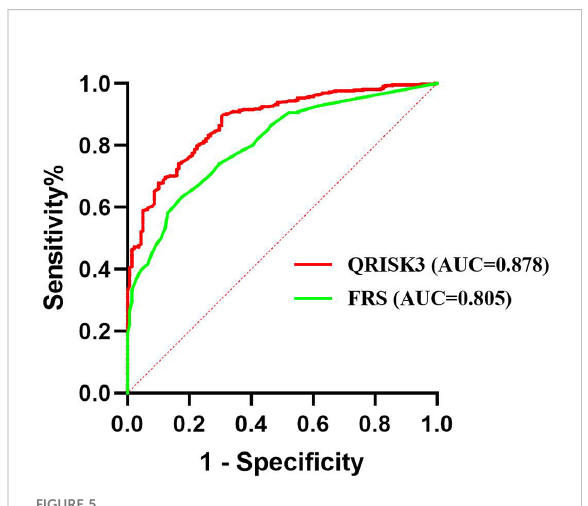
FIGURE 5 ROC for QRISK3 and FRS. Legend: ROC curves were drawn without distinguishing the risk levels, and the AUC of QRISK3 and FRS were high, which were 0.878 and 0.805, respectively. ROC, Receiver operating characteristics; AUC, area under the ROC curve; QRISK3, QRESEARCH Risk estimator version 3; FRS, Framingham risk score.